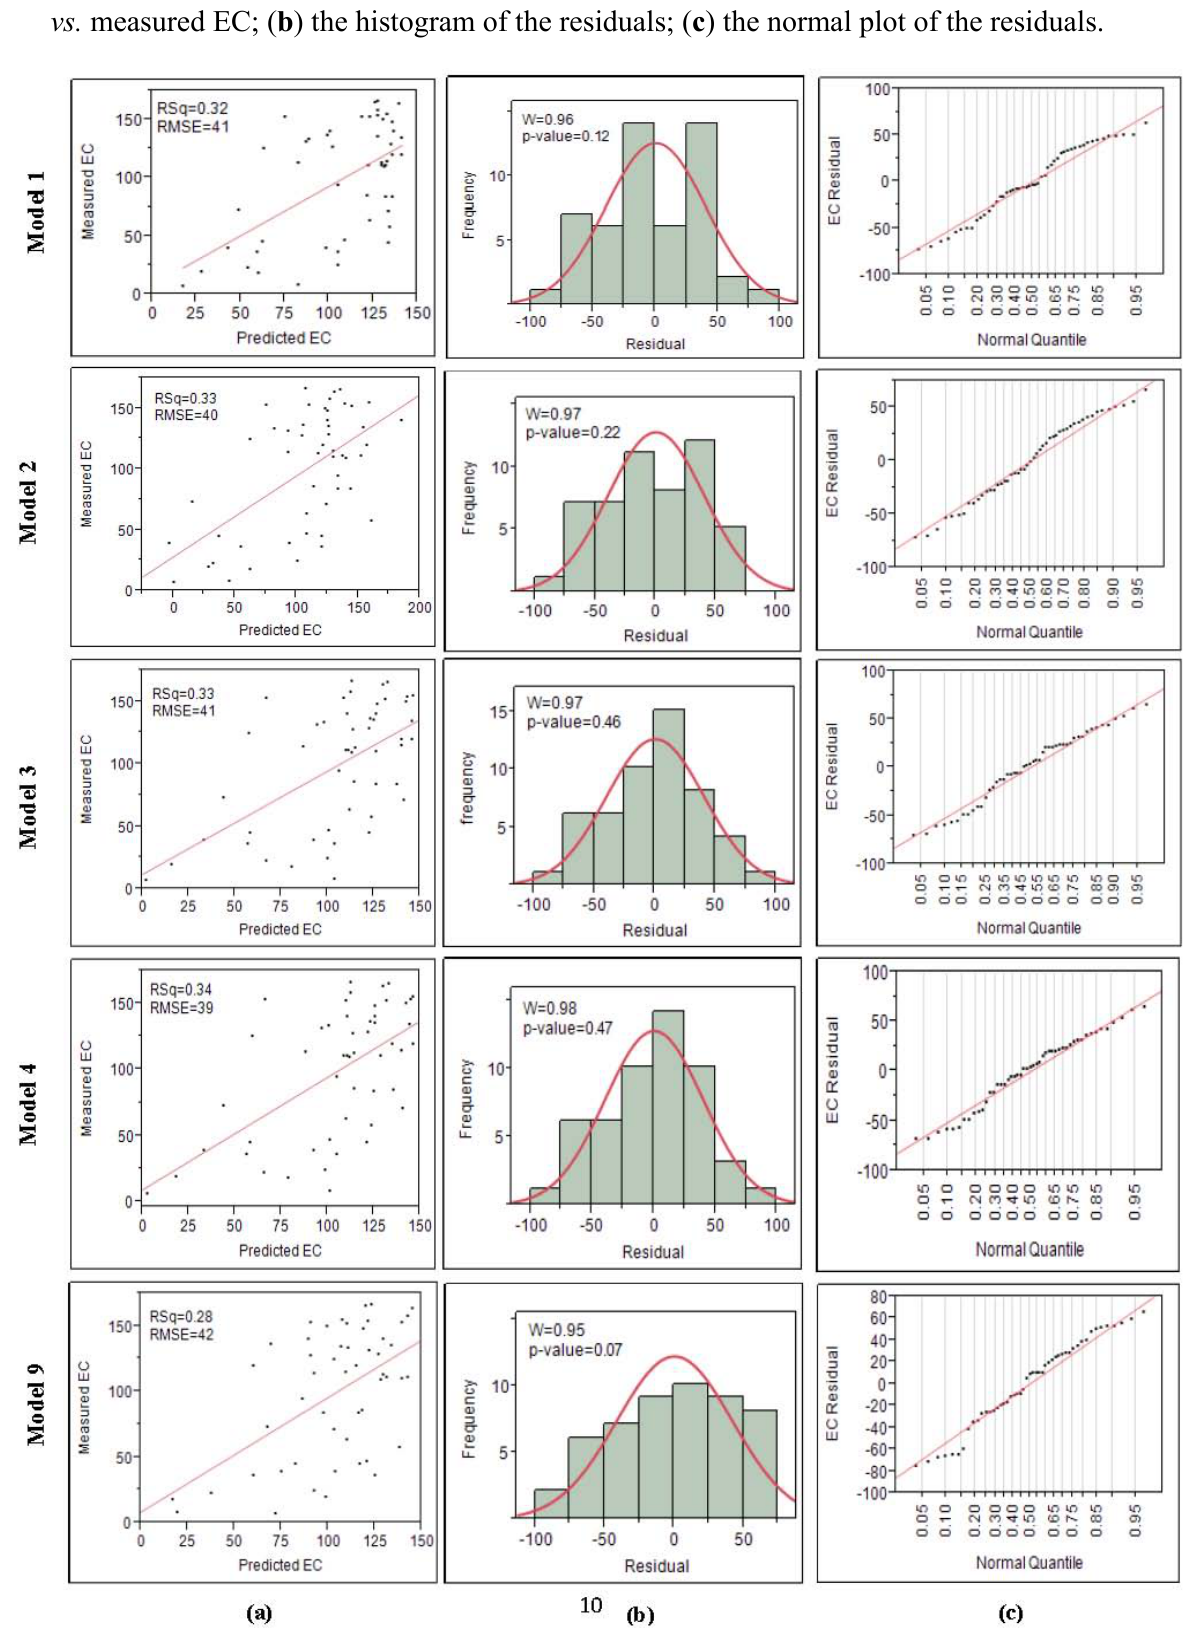
Figure 3. Validation of the developed regression models: ( a ) scatterplots of the predicted vs. measured EC; ( b ) the histogram of the residuals; ( c ) the normal plot of the